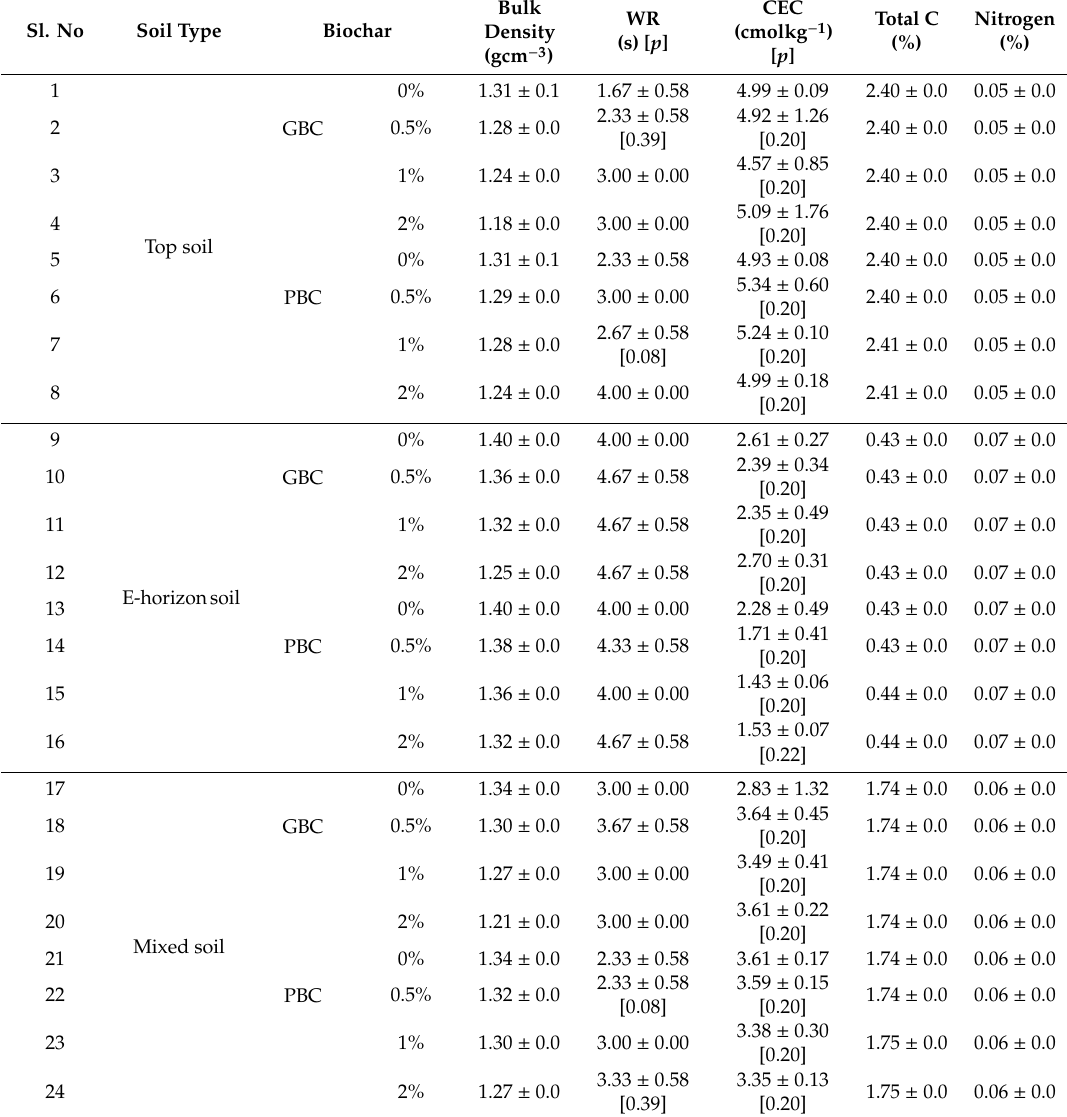
Table 2. E ff ect of biochar type and application rates on bulk density, water repellency, cation exchange capacity and total carbon, nitrogen on podzolic